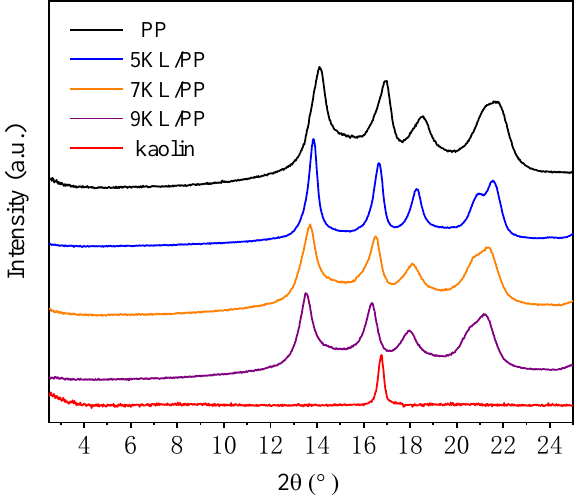
Figure 14. X-ray diffraction patterns. The characteristic peak (001) of pure kaolin (red line) is observed around 16.6 ◦ . Ac- cording to the Bragg equation, the interlayer spacing d = n λ /2sin θ , where n = 1, λ = 0.15406 nm, and θ is the angle corresponding to the diffraction peak. Then, the calculated interlayer spacing of pure kaolin is 0.531 nm. The XRD pattern of pure PP polymer (black line) exhibits four characteristic peaks. When kaolin is packed into PP polymer, its four characteristic peaks move slightly to lower angles, which demonstrates the presence of the effect of kaolin dispersed in the polymer